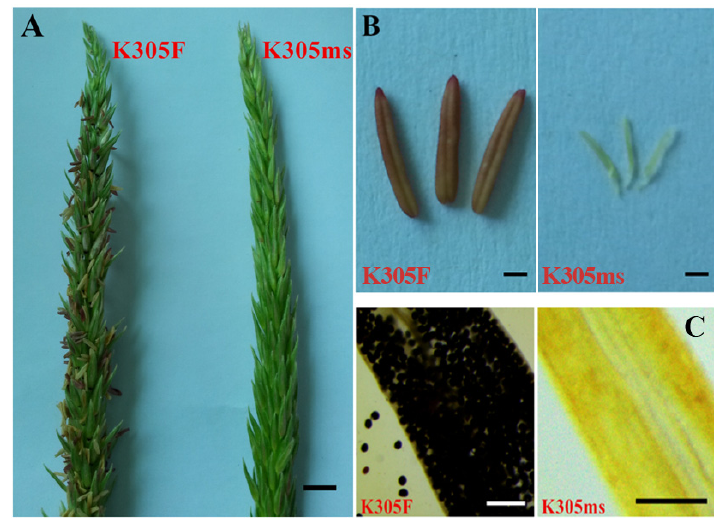
Figure 1. Phenotypic comparison of ms305 and fertile sibling. ( A ) The inflorescence of ms305 and its fertile sibling plant, scale bars = 10 mm; ( B ) The anther of ms305 and its fertile sibling plant, scale bars = 1 mm; ( C ) Viable pollen grains from fertile sibling and nonviable pollen grains from ms305 after I2-KI staining, scale bars = 1 mm. Fertile sibling, K305F; ms305 , K305ms.